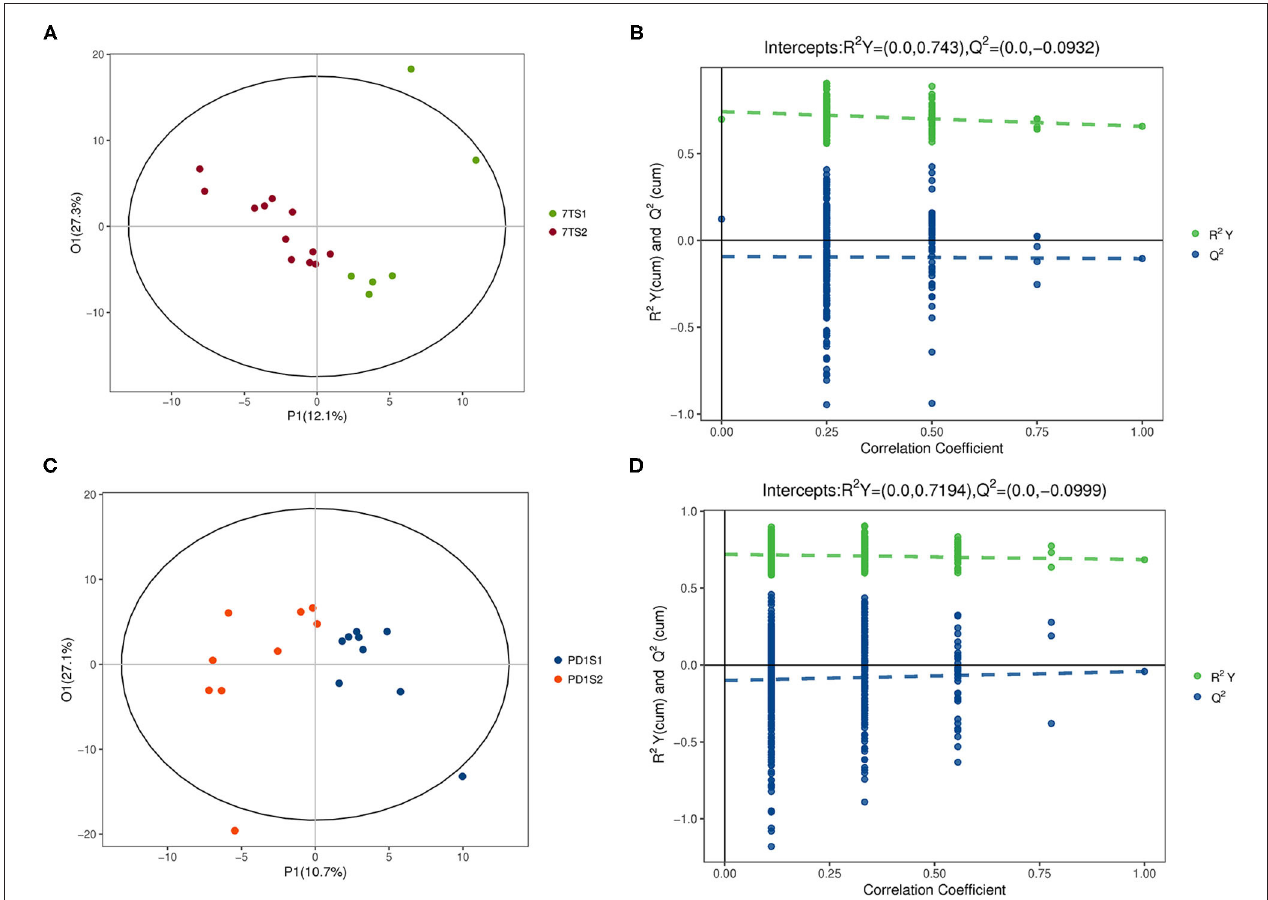
FIGURE 3 | The multidimensional results in negative ionization modes are shown in this figure. (A,B) Are from the 7-day prognosis group; (C,D) are from the PD-1 expression group. (A) OPLS-DA score plot: the 7TS1 group vs. the 7TS2 group. (B) OPLS-DA validation plot intercepts: the 7TS1 group vs. the 7TS2 group; R2Y = (0.0, 0.743), Q2 = (0.0, − 0.0932). (C) OPLS-DA score plot: the PDS1 group vs. the PDS2 group. (D) OPLS-DA validation plot intercepts: the PDS1 group vs. the PDS2 group; R2Y = (0.0, 0.7194), Q2 = (0.0, −